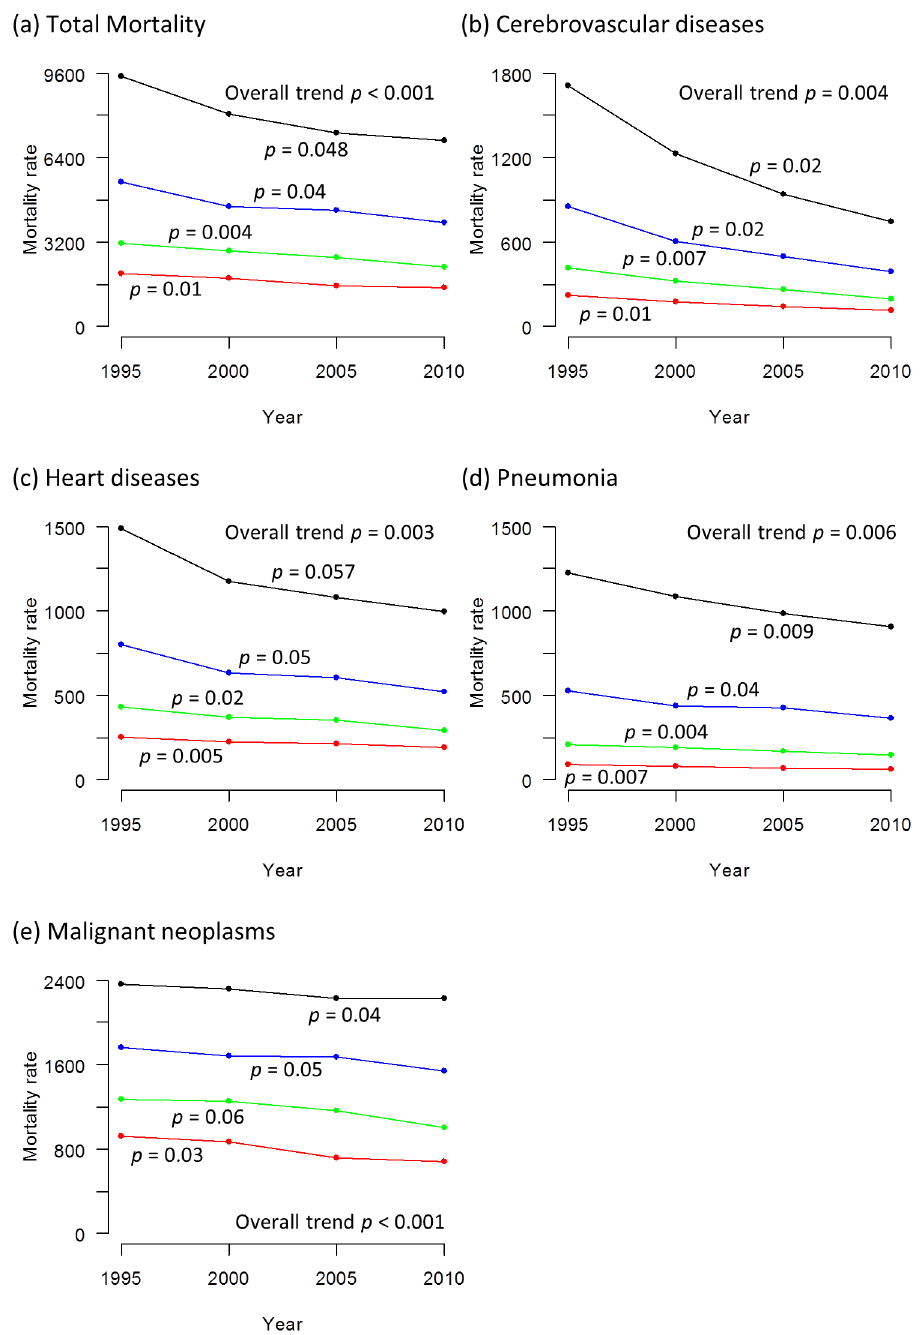
Fig 4. Trends in total mortality rate and mortality rates from specific causes in men from 1995 to 2010. (a) total mortality rate. Mortality rate from (b) cerebrovascular diseases (c) heart diseases (d) pneumonia (e) malignant neoplasms. The mortality rate is calculated as the number of deceased divided by the estimated population x 100,000. The black line represents those aged 80 – 84 years, the blue line represents those aged 75 – 79 years, the green line represents those aged 70 – 74 years and the red line represents those aged 65 – 69 years. The p values signify statistical significance for the trends in each age